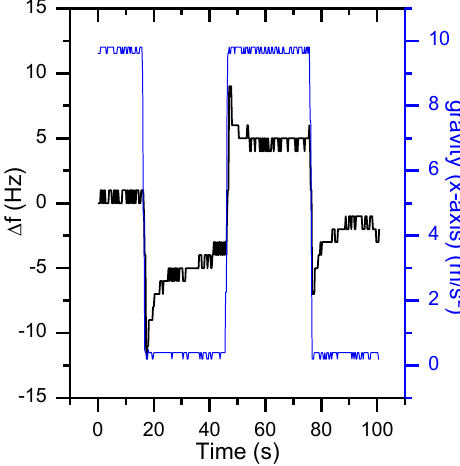
Figure 20. Frequency response of a 90° rotation around the sensors x axis.